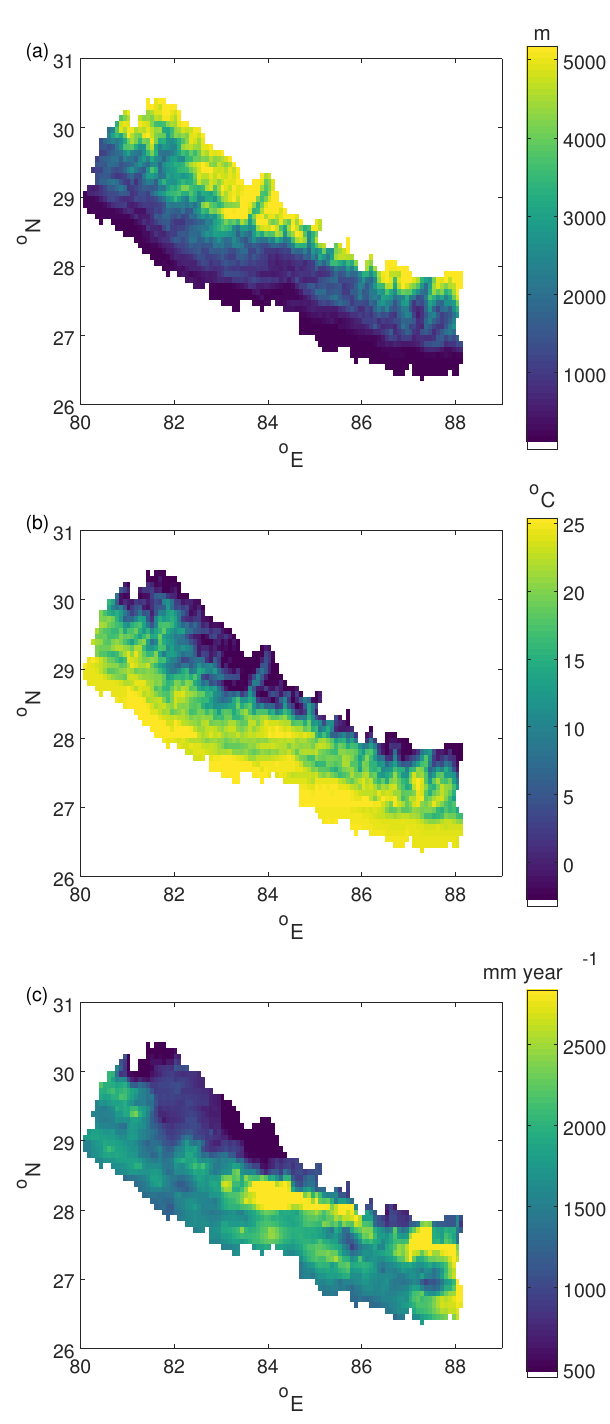
Figure 1. Mean pixel ( a ) elevation, ( b ) temperature, and ( c )